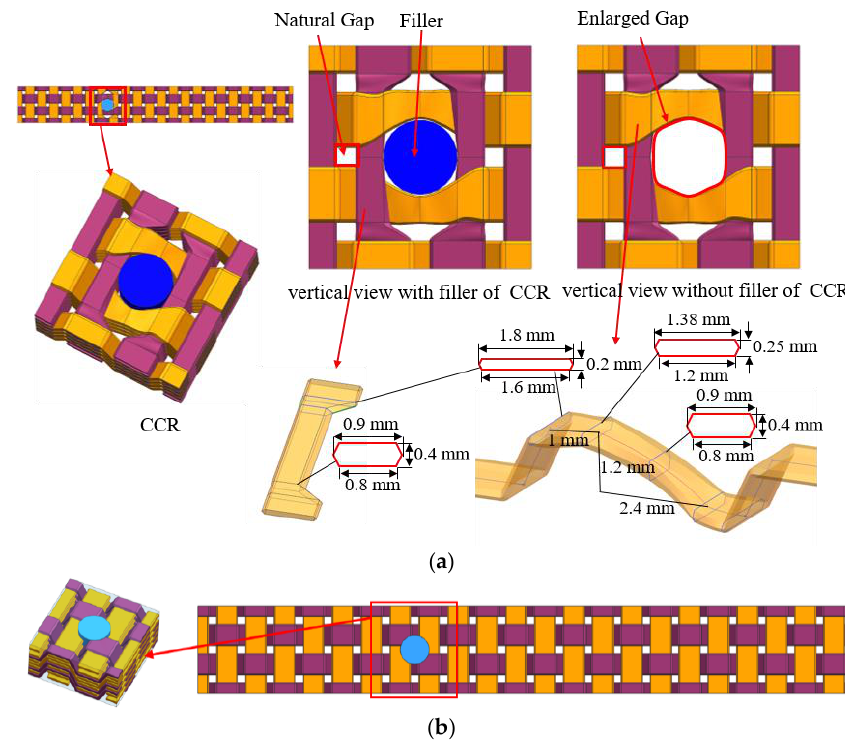
Figure 3. Internal structures of Geo 1 and 2: ( a ) Geo1, ( b ) Geo2.